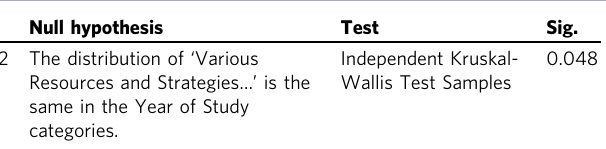
Table 9 Non-parametric Kruskal-Wallis test of differences in rank scores given in Question 1. ( ‘ History Class must …’ ) regarding the year of master study (1st or 2nd year of the Master ’ s Degree).